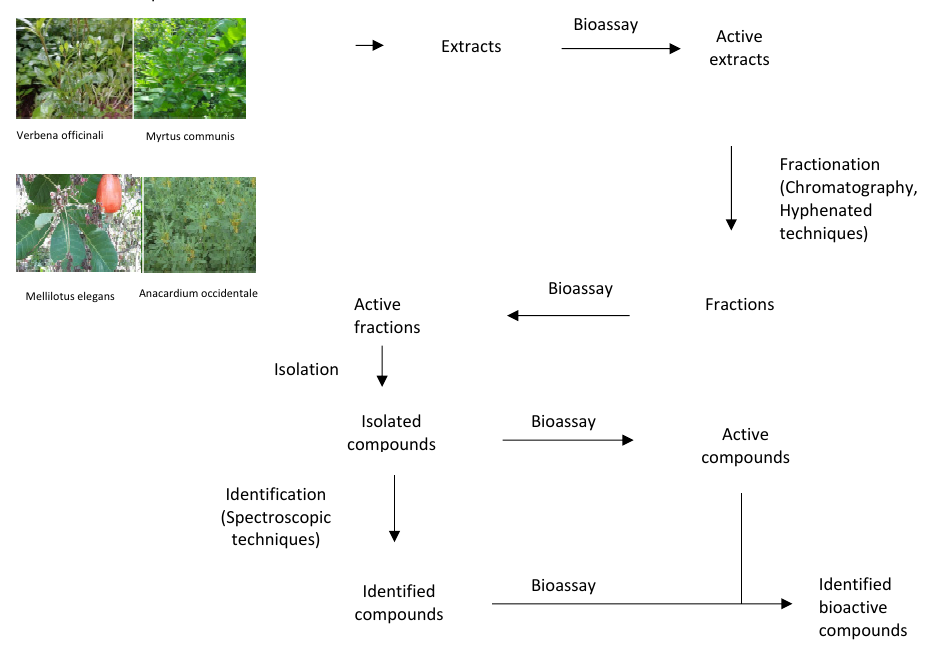
Figure 2. The process of discovering bioactive Figure 2 . The process of discovering bioactive compounds